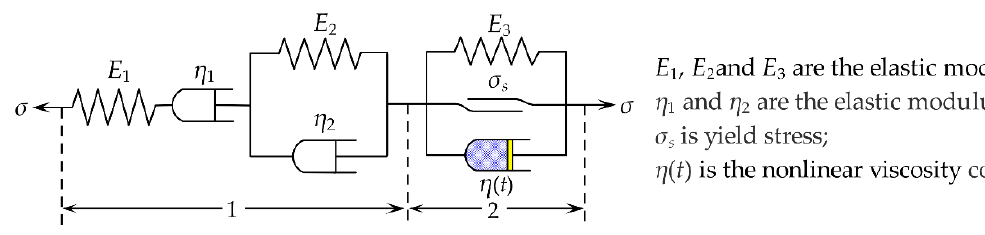
Figure 11. Improved nonlinear viscoelastic – plastic creep model